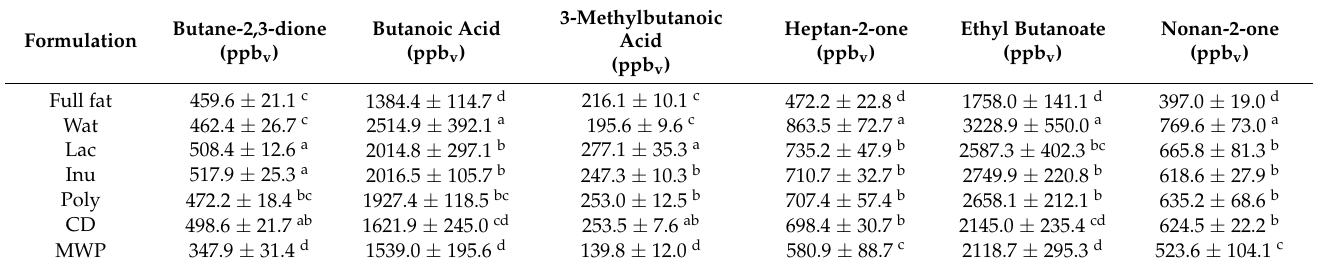
Table 7. Headspace concentration of aroma compounds in different emulsion